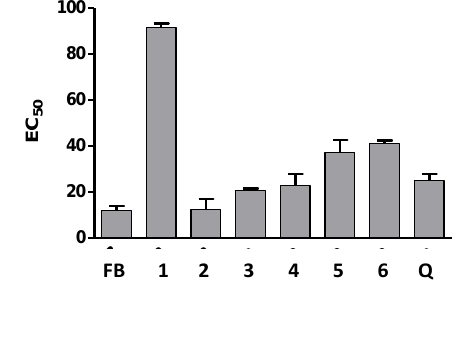
Figure 3. Antioxidant activity against LDL peroxidation of biflavonoids and BF . Results in μg/mL (mean ± S.D; n =